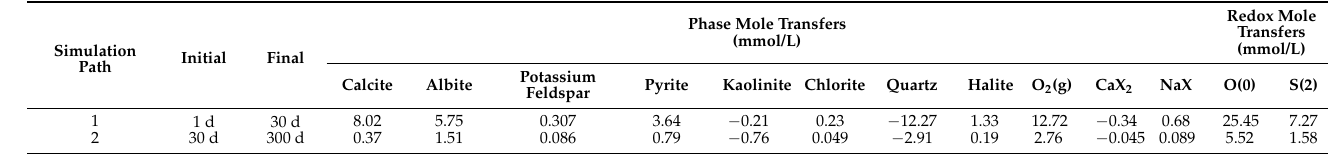
Table 3. Results of inverse geochemical